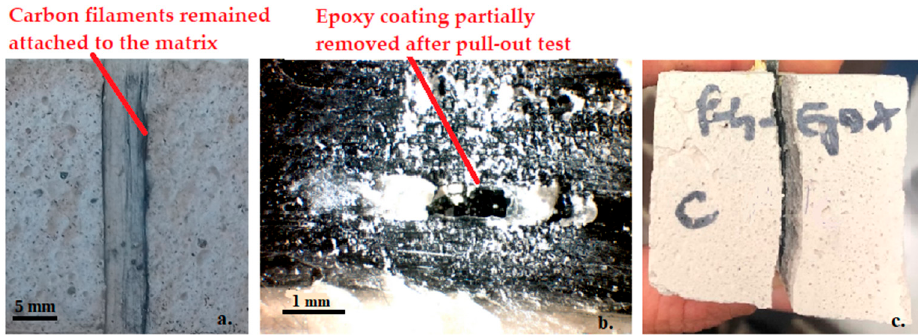
Figure 7. ( a ) Contact surface between dry carbon yarns (C-Dry) and inorganic matrix after pull-out tests, ( b ) external surface of epoxy coated carbon yarn (C-E) after pull-out, ( c ) matrix breakage.